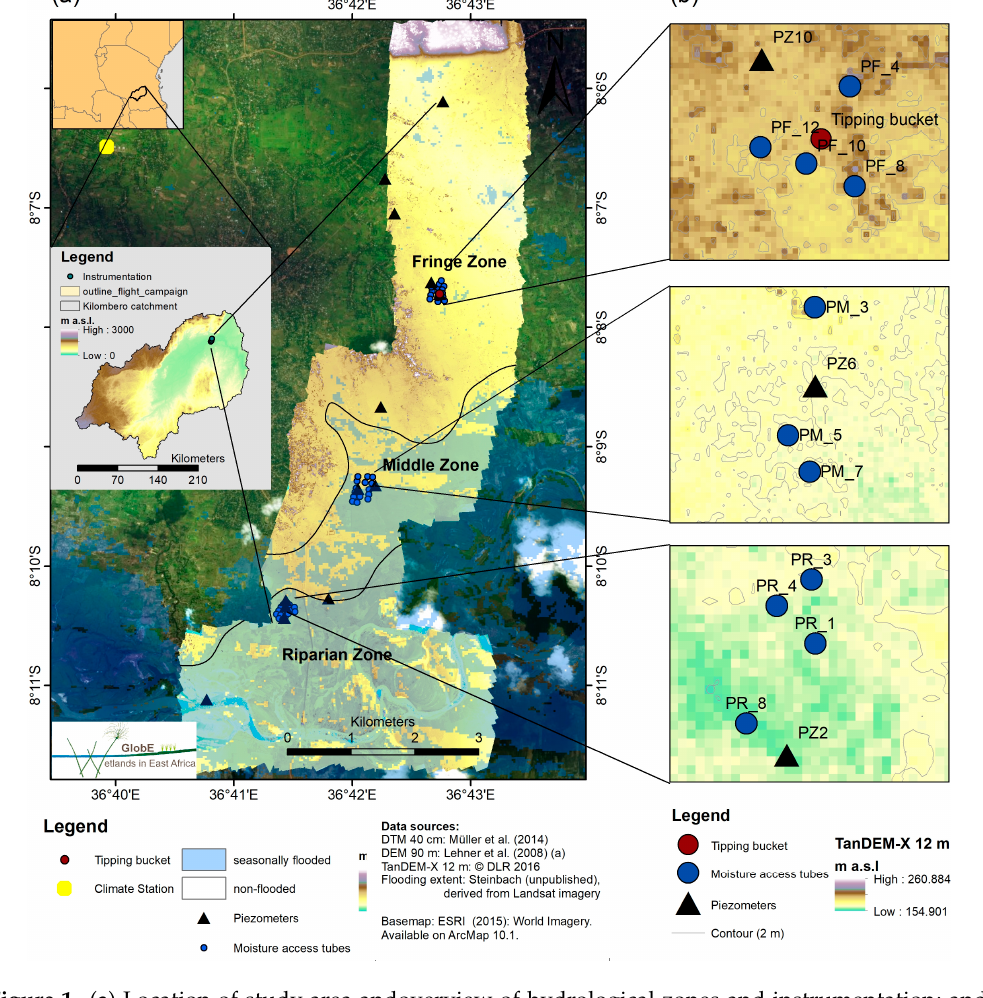
Figure 1. ( a ) Location of study area andoverview of hydrological zones and instrumentation; and (b) detailed instrumentation at each hydrological zone used for modeling.